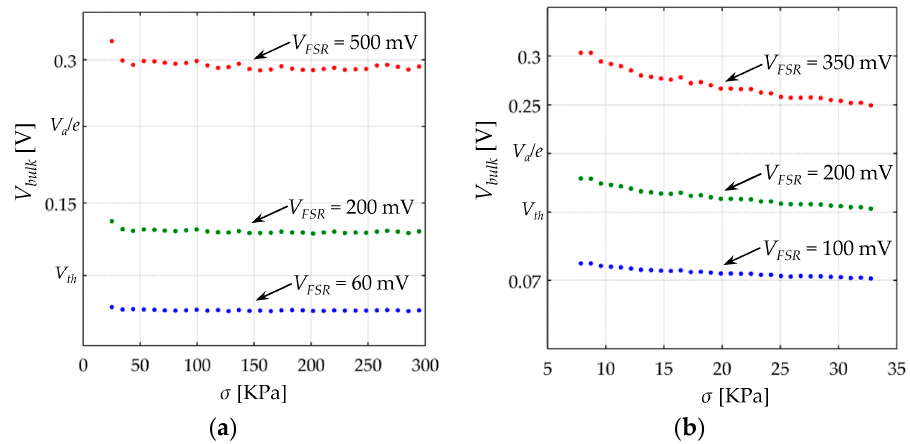
Figure 16. Plot of V bulk as function of σ for different values of V FSR . The values of V th and V a are listed on Table 3. Data for: ( a ) FlexiForce A201-1 and ( b ) Interlink FSR 402.